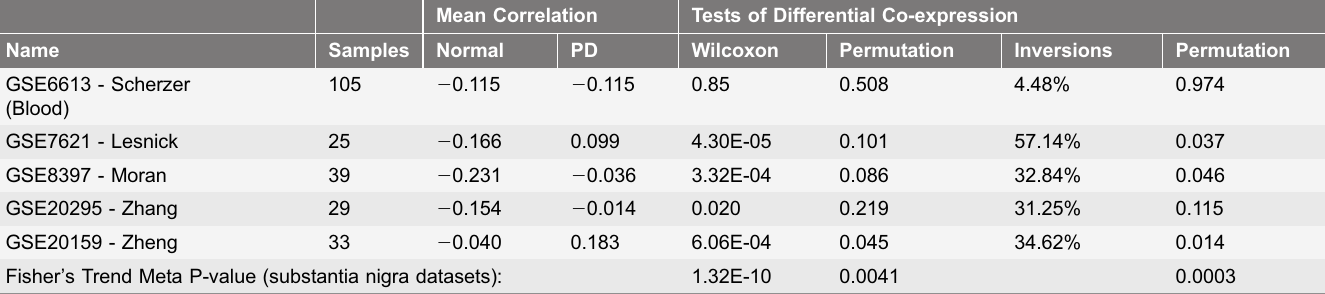
Table 1. Differential co-expression between SNCA and IFN- c genes in Parkinson’s gene expression studies. Mean Correlation